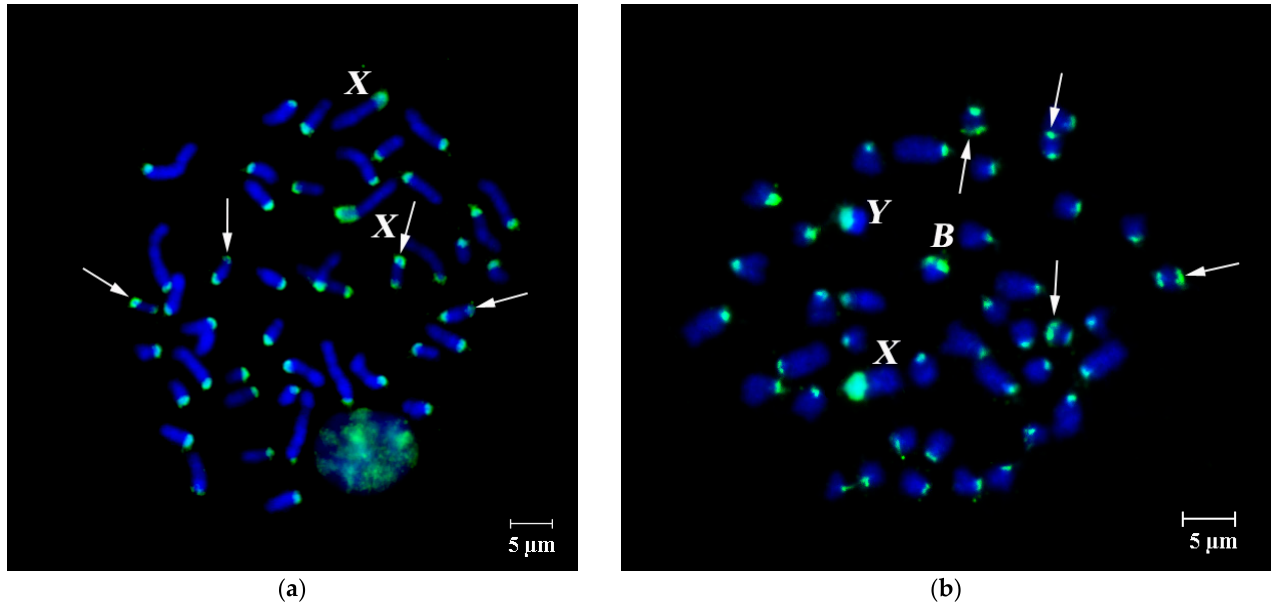
Figure 4. FISH of microdissected DNA probe (PCPAflaCEN, green) generated from the pericentromeric region of a large autosome on metaphase chromosomes of: ( a ) the same A. flavicollis specimen, from which the probe was derived (no Bs, female #1851 from Saint-Petersburg region, Russia); ( b ) another A. flavicollis specimen (with one B, male #24448 from Novgorod region, Russia). Arrows indicate the signal from PCPAflaCEN probe in telomeric regions of two pairs of small autosomes; B chromosome and sex chromosomes are marked by corresponding letters. DAPI chromosome staining in blue. Scale bar 5 µm.